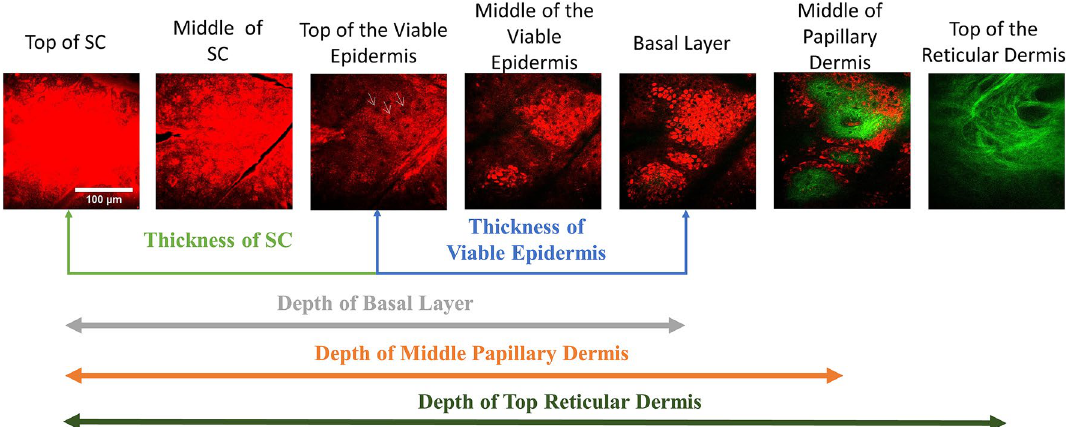
Figure 11. The HGM images of human skin obtained at different depths showing different skin structures. THG and SHG are shown with false red and green colors. The definitions of 5 different parameters related to the layer thickness are displayed. SC Stratum corneum. Scale bar: 100 μm. White arrow: